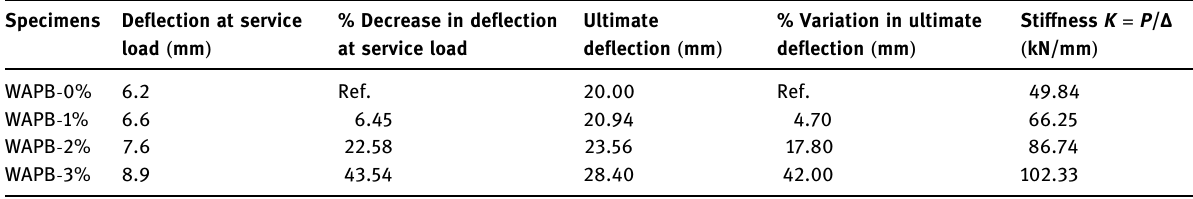
Table 12: Midspan de fl ections of specimens in service and ultimate loads